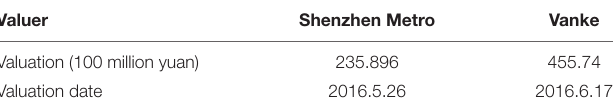
TABLE 4 | Changes in the valuation of major assets of Qianhai